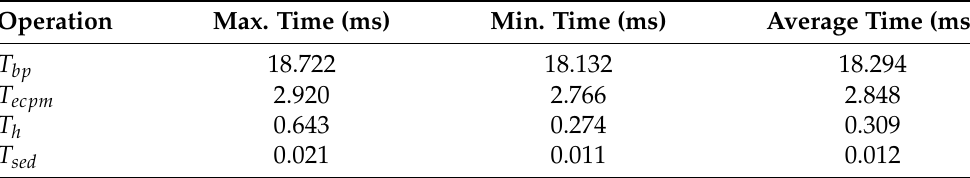
Table 5. Execution time for a Raspberry PI 4.